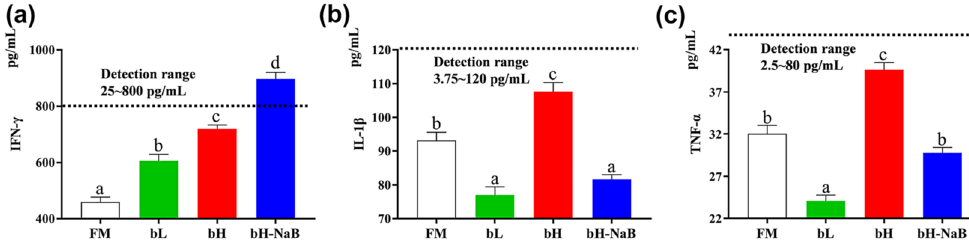
Figure 2. Serum immune indexes of juvenile hybrid grouper fed experimental diets for 8 weeks. Values are the means ± SE (n = 4); Significance was evaluated by one-way ANOVA followed by Tukey multiple range tests. FM control diet, bL containing 1.5% 7S diet, bH containing 6% 7S diet, bH-NaB containing 6% 7S and 0.13% NaB diet. Dashed horizontal line: detection limit. ( a ) IFN-γ, interferon-gamma; ( b ) IL-1β, interleukin-1 beta; ( c ) TNF-α, tumor necrosis factor-alpha. a,b,c,d Mean values denoted by different superscripted letters differ significantly at the P < 0.05 level.